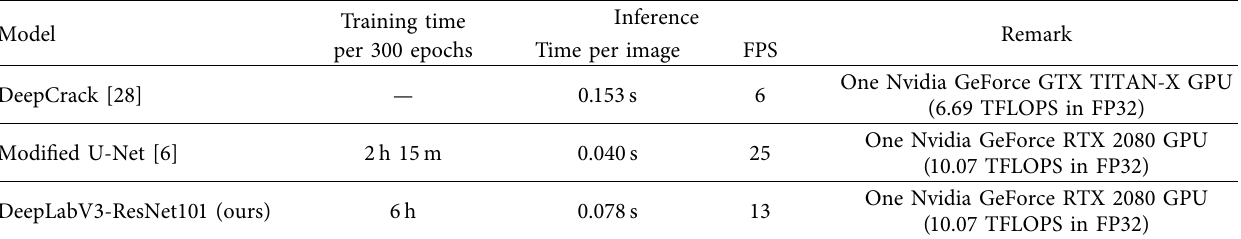
Table 4: Time analysis regarding three model architectures based on input images of 512 × 512